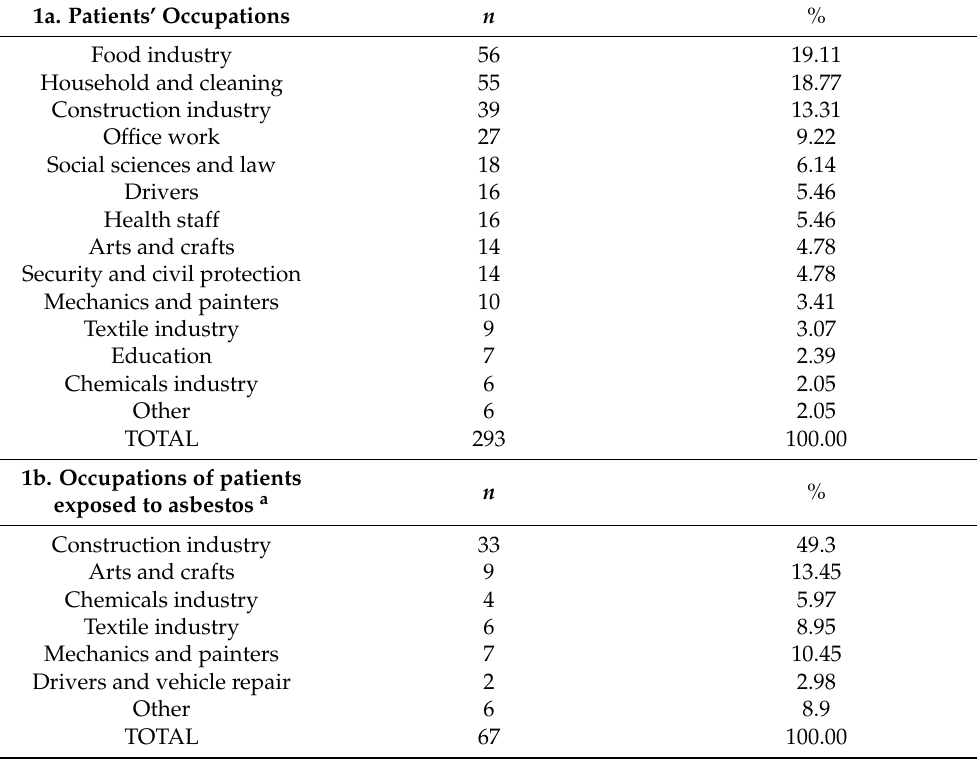
Table 1. Patients’